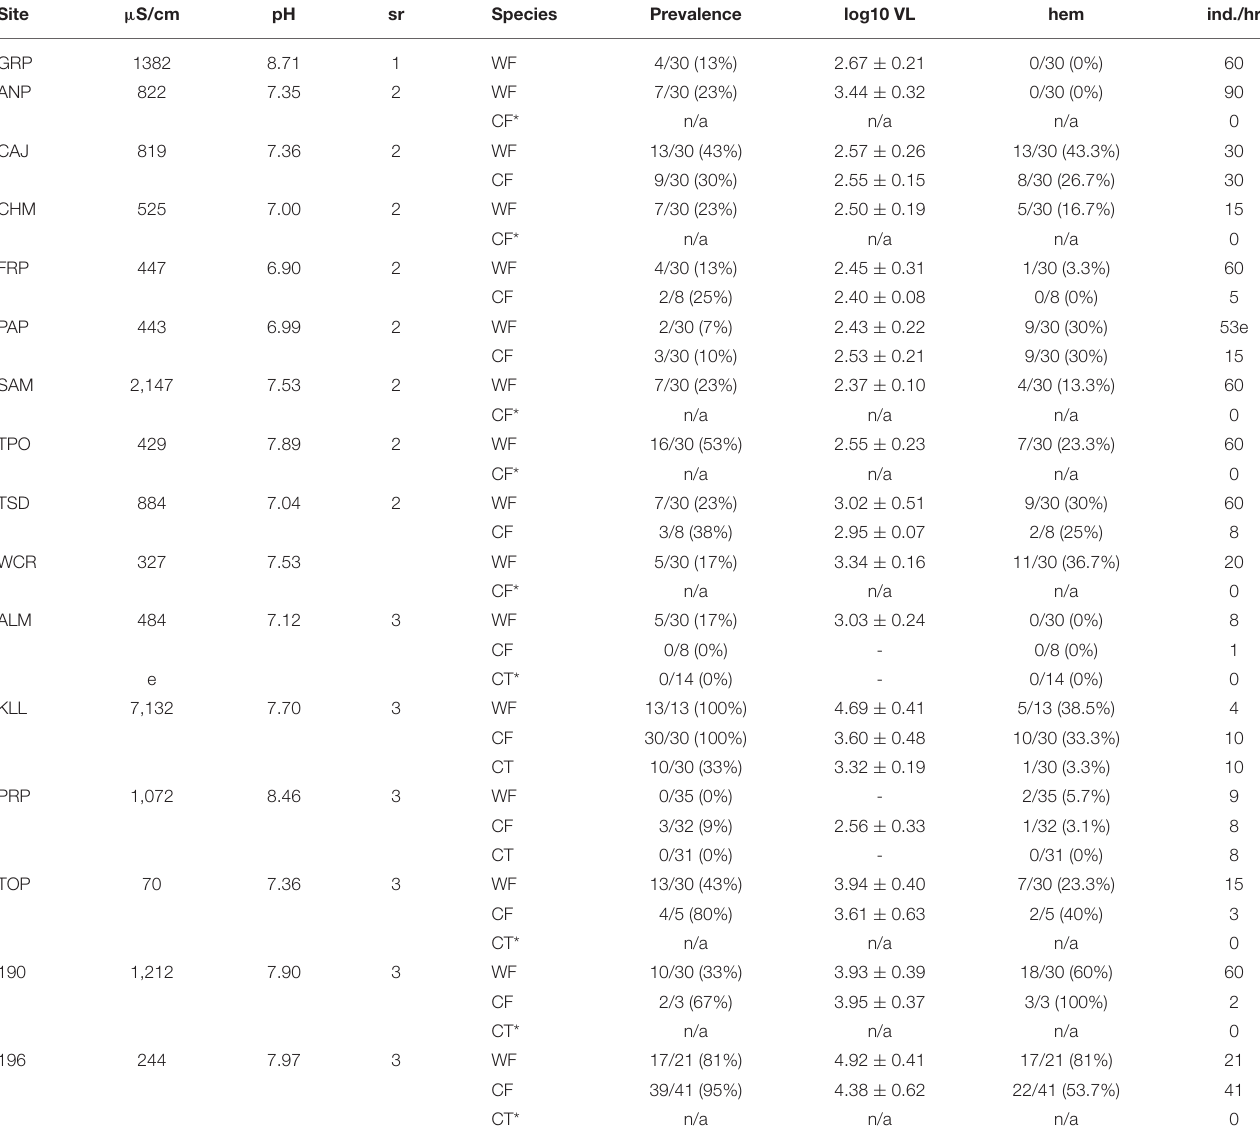
TABLE 2 | Field sites in Alberta and the Northwest Territories where aquatic amphibian life stages were sampled for ranavirus in 2017. Site µ S/cm pH sr Species Prevalence log10 VL hem